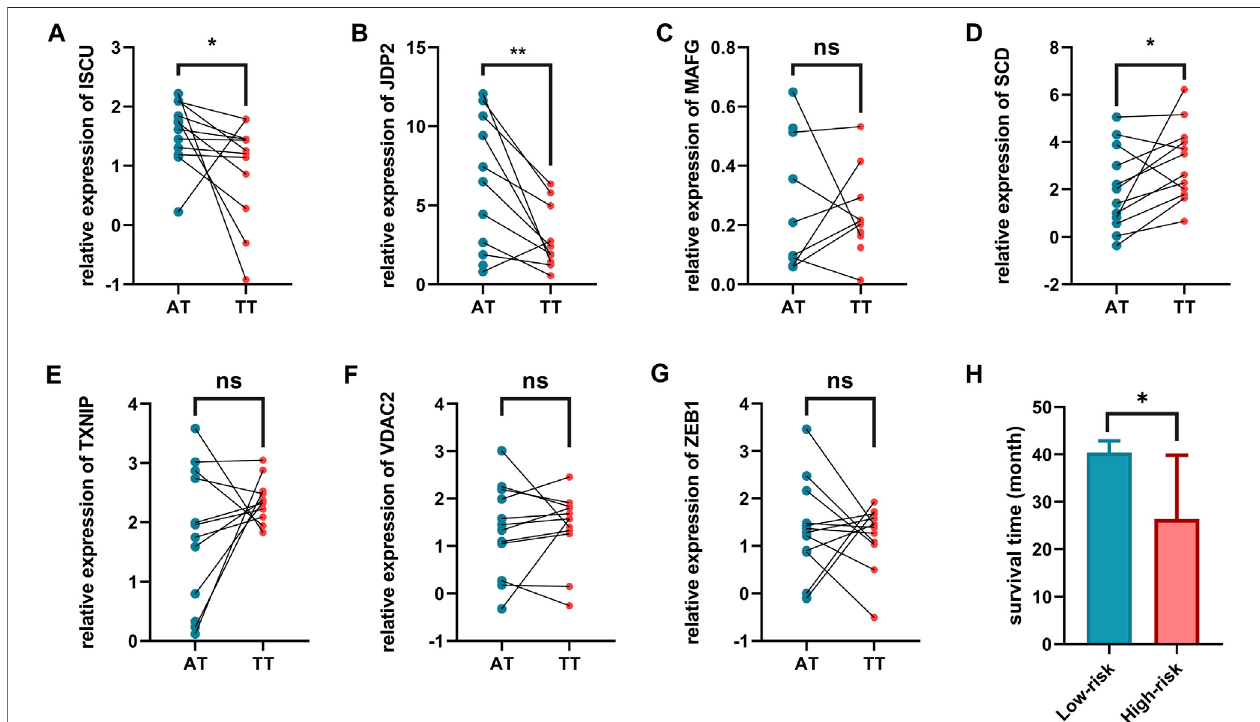
FIGURE8| Validationofexpressionlevelsofeightferroptosisrelatedgenesintumortissues.andadjacentnormaltissues. (A) ISCU, (B) JDP2, (C) MAFG, (D) SCD, (E) TXNIP, (F) VDAC2, (G) ZEB1, (H) Comparison of survival time among patients with different risk characteristics. AT, adjacent normal tissues. TT, tumor